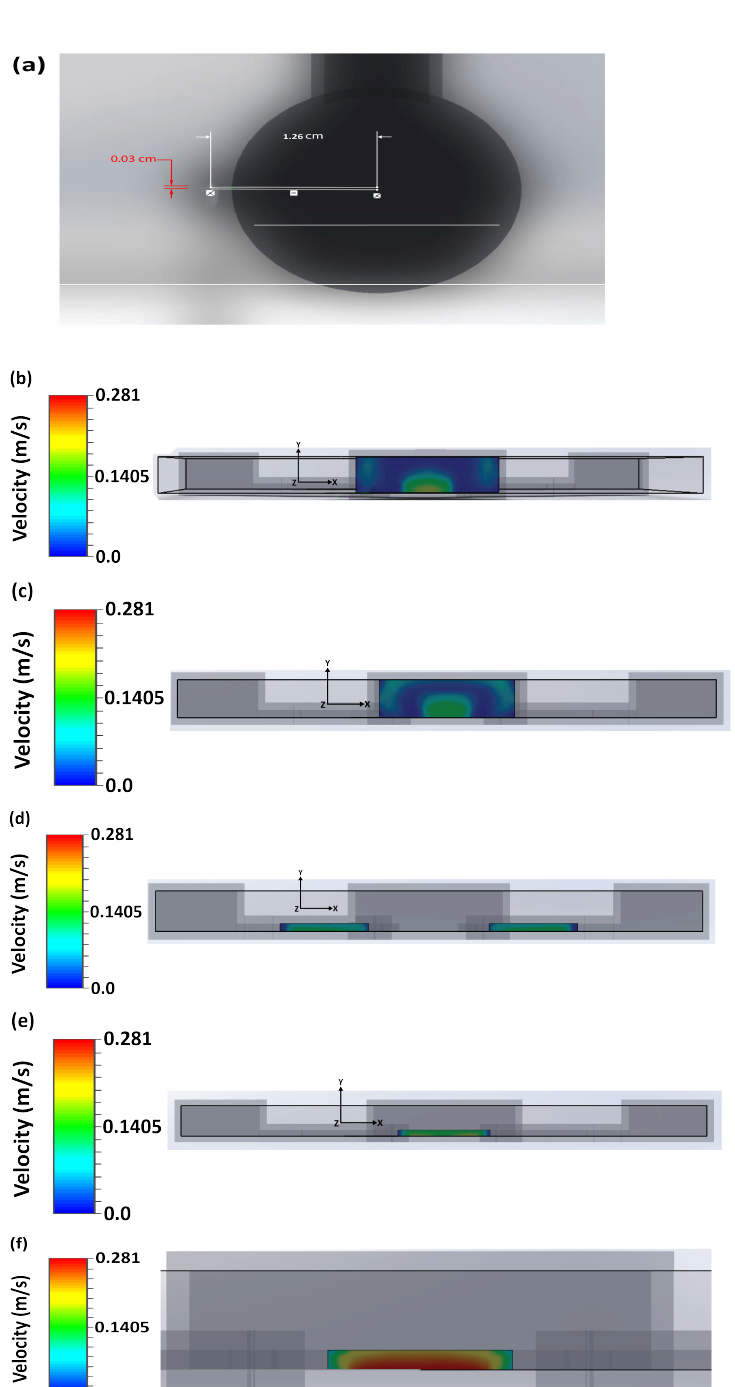
Figure 6. ( a ) The origin (0, 0) location for reference from the center point of the outlet well of the simulated 3D microfluidic structure to determine distances of different cross-sectional portions of microchannels. Directions away from and toward this origin mean positive and negative distances respectively. ( b ) (0, 0) origin point- cross-section of the portion of outlet. ( c ) 0.04 cm positive distance with respect to the origin- cross-section of the portion of outlet. ( d ) 0.28 cm negative distance with respect to the origin- cross-section of the rectangular common path. ( e ) 0.35 cm negative distance with respect to the origin- cross-section of rectangular two inlet paths. ( f ) 0.155 cm positive distance with respect to the origin- cross-section of the portion of the